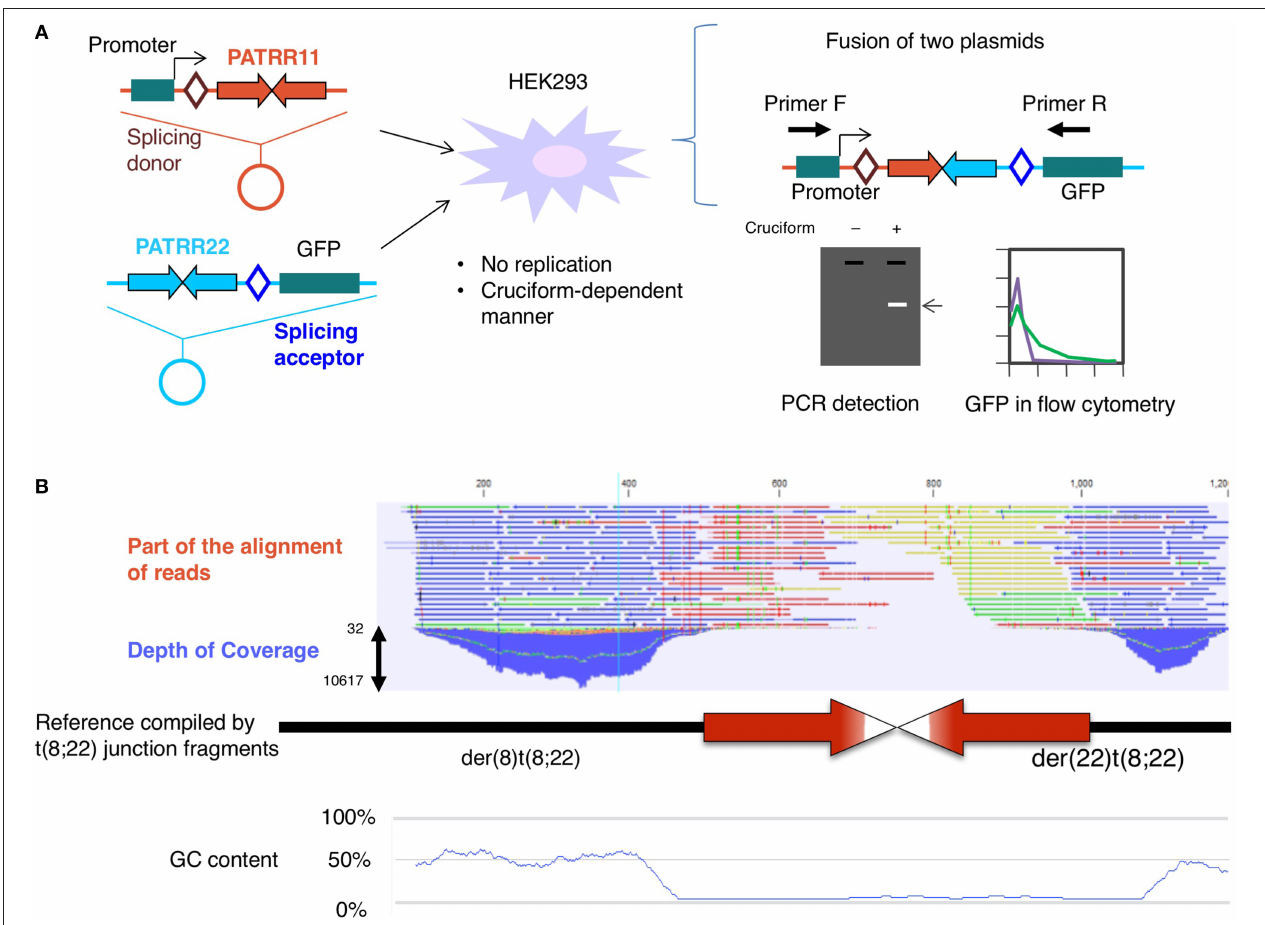
FIGURE 1 | (A) Translocation model system. Two plasmids, one harboring a promoter, splicing donor, and PATRR11, and the other carrying PATRR22, a splicing acceptor, and a coding region of the GFP gene, were simultaneously transfected into HEK293 cells. After 24 h, fusion molecules generated by joining of the PATRR11 and PATRR22 at the center were detected by PCR or GFP-positive cells were monitored by flow cytometry (Inagaki et al., 2013). (B) Determination of the PATRR8 sequence by next-generation sequencing. Although the depth of the coverage was low at the center of the palindrome, massive parallel sequencing was able to fill the entire region of the palindrome (Mishra et al.,